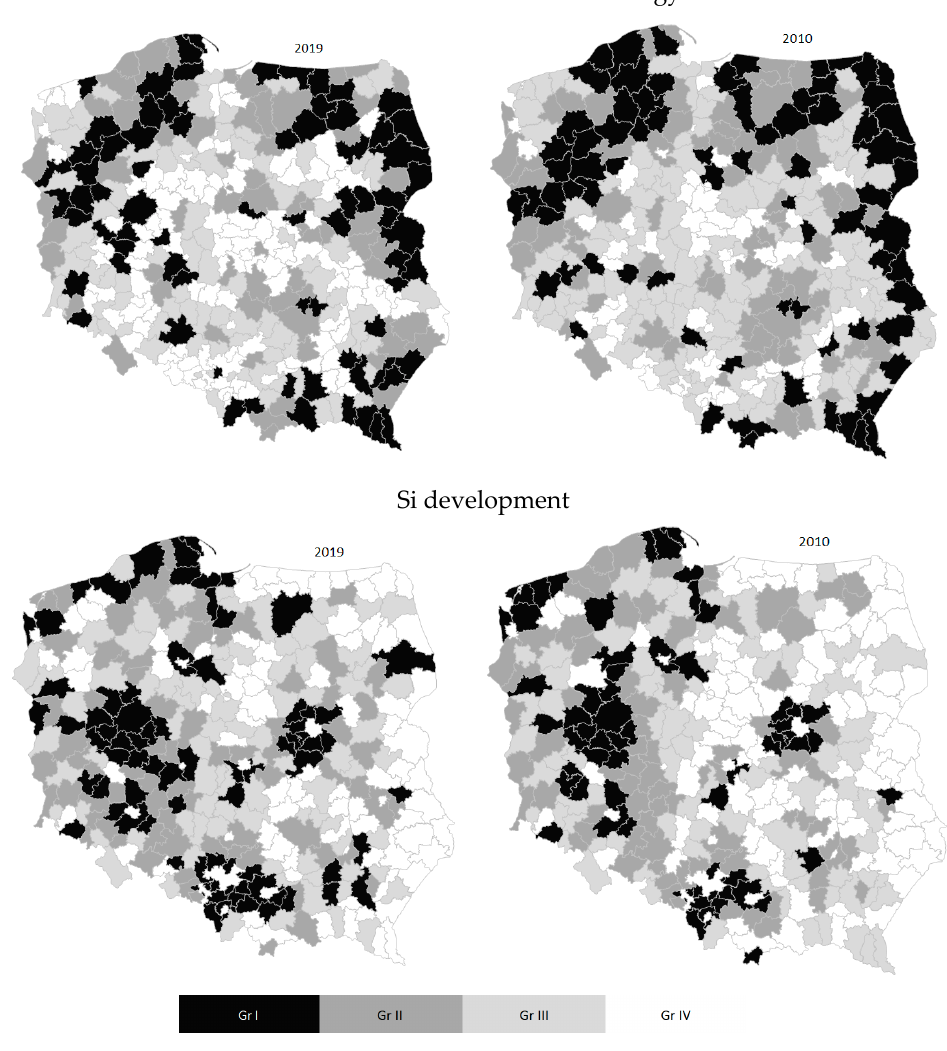
Figure 2. Quartile groups of synthetic measure (development; natural environment and ecology) of poviats in Poland in 2010 and 2019. Source: own study based on the BDL CSO data. The poviats in Poland in 2010 and 2019 are characterized by disproportions in terms of development variables, as well as the natural environment and ecology. Poviats distinguished by a higher level of natural environment and ecology are not distinguished by a higher measure of development. The synthetic measure of the natural environment potential in group I ranged from 0.21 to 0.23 (2010 to 2019), and in group IV, it ranged from 0.10 to 0.11. The ranges in these groups were 0.02 and 0.01, respectively, which indicates a slight variation in the studied range.